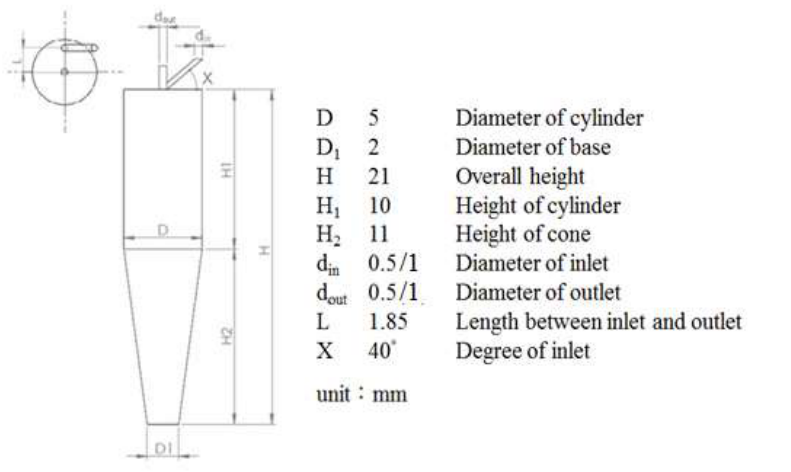
Figure 2. Dimensions and design parameters of microcentrifuge tube (0.2 mL) as a cyclone separator.